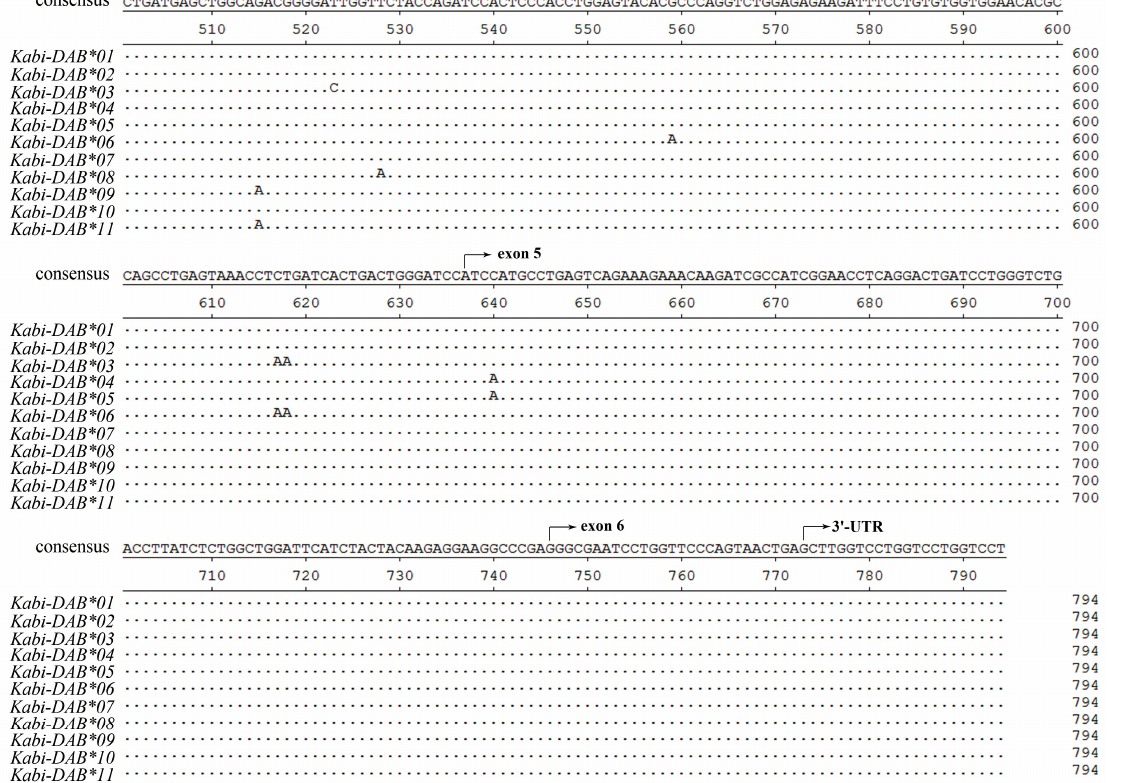
Figure 1. Sequence alignment of major histocompatibility complex ( MHC ) class II B cDNAs in eight stone flounder individuals. Nucleotides identical to the consensus are indicated by dots. The beginning of each exon is marked above the sequences.